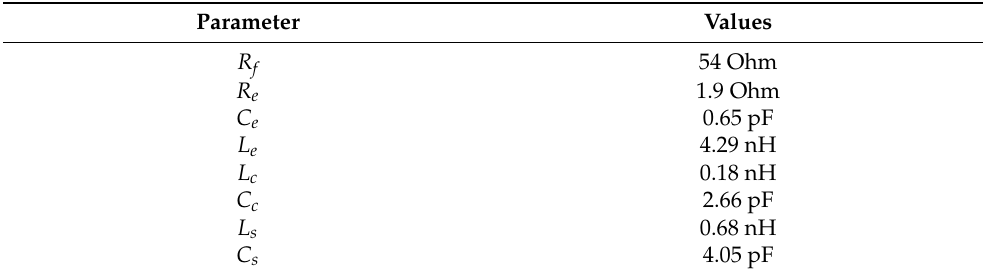
Table 1. Optimized values of the equivalent model representing the 2 × 1 antenna microstrip patch antenna array with slotted MTM-DS.